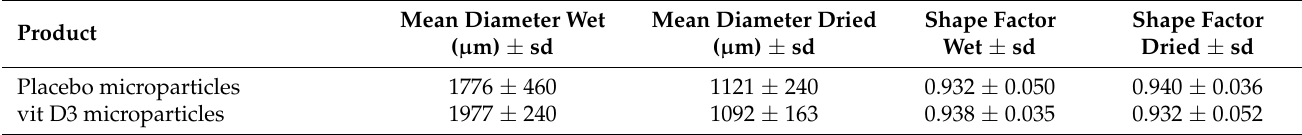
Table 4. Average diameters and shape factors of wet and dried microparticles.